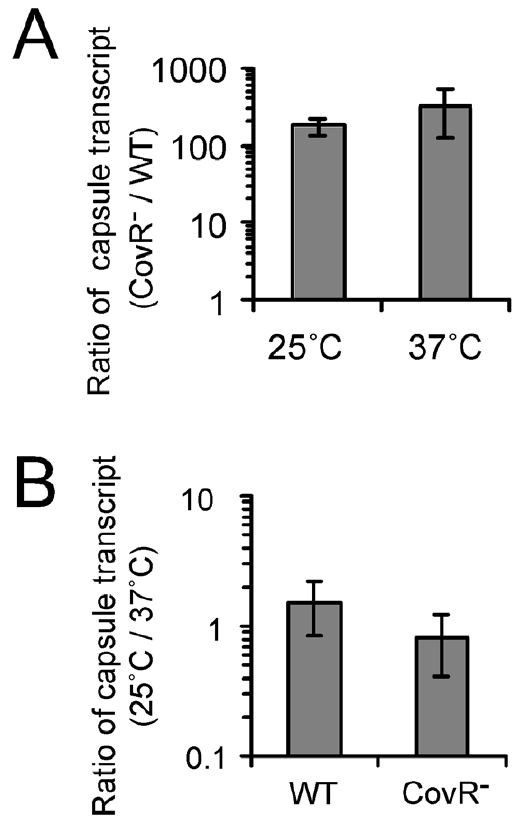
Figure 1. Capsule thermoregulation occurs at a post-transcrip- tional level. (A) The ratio of the capsule transcript quantity of the CovR null strain to that of the wild type. S. pyogenes cells were grown on THY agar plates at 37 u C overnight ( , 18 hrs) and the fully grown colonies were incubated for another six to eight hrs at each temperature (25 u C or 37 u C). After RNA was extracted from the colonies, the relative amounts of the capsule transcript between strains were measured through real time-RT (reverse transcriptase) PCR. Regardless of the incubation temperatures, the capsule transcript quantity in the CovR 2 strain was more than 100 times higher than that in the wild type, confirming that the CovRS two-component system regulates the expression of the capsule transcript at the transcriptional level. (B) The ratio of the capsule transcript quantity at 25 u C to that at 37 u C. Regardless of the incubation temperatures, the capsule transcript quantity in both strains (the wild type and the CovR 2 strain) was the same, indicating that thermoregulation of capsule production occurs at a post-transcriptional level. The following strains were used: wild type (WT), HSC5; CovR 2 strain (CovR 2 ),